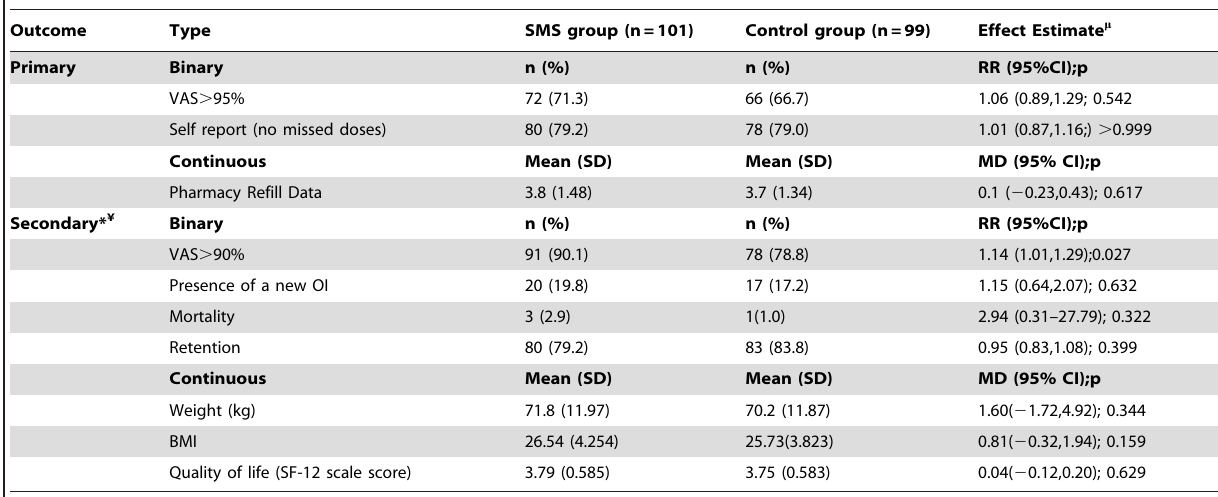
Table 2. Outcomes at 6